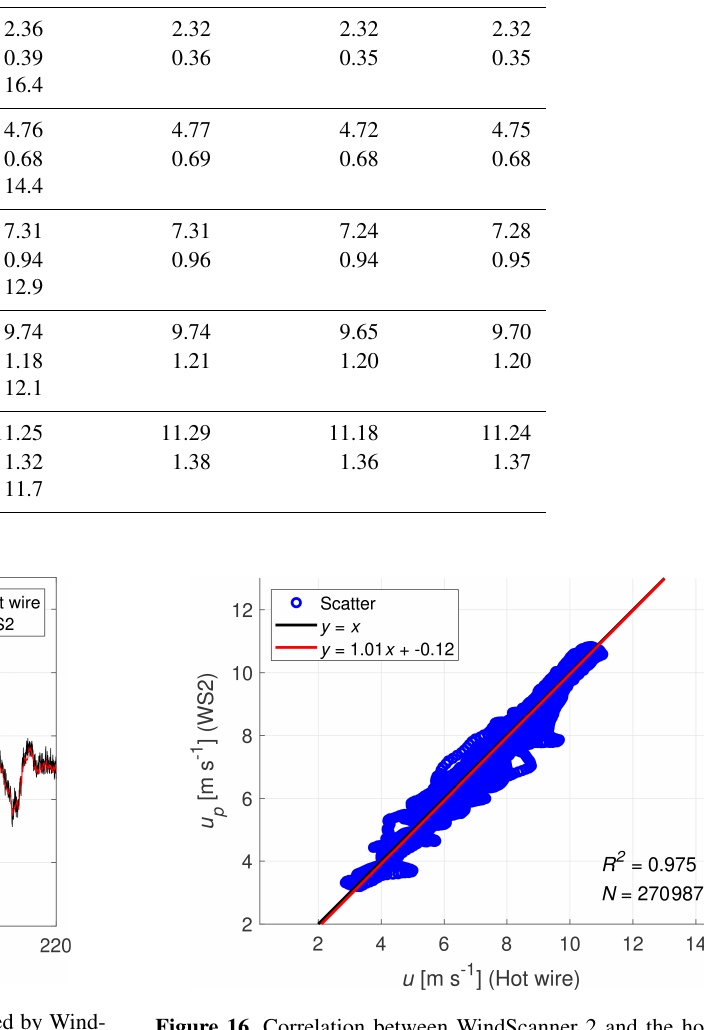
Figure 16. Correlation between WindScanner 2 and the hot-wire anemometer for a coefficient of variation of 12.9% (Case 2c).